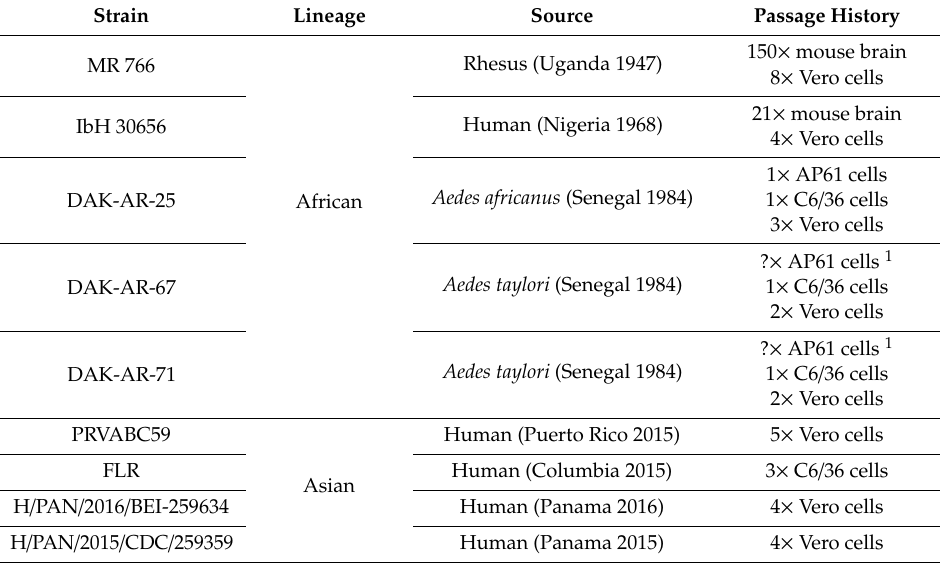
Figure 1. Phylogenetic relationships of Zika virus strains used in this study. Maximum-likelihood phylogeny of full-length open-reading-frame nucleotide sequences using Zika virus strains in this study (circles) and reference sequences isolated from humans, non-human primates, and mosquitoes. At least one representative strain from each documented Zika virus (ZIKV) clade is included in the phylogenetic tree. Table 1. Summary of characteristics of ZIKVs used in this